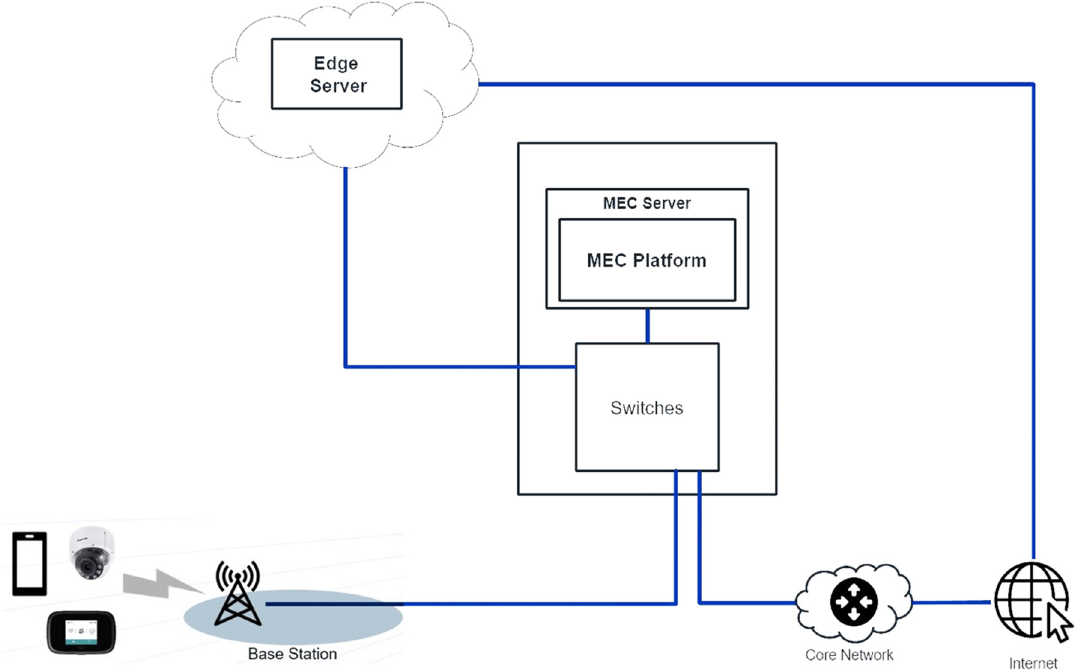
Figure 1. UE and Multi-access Edge Computing (MEC) initiative.